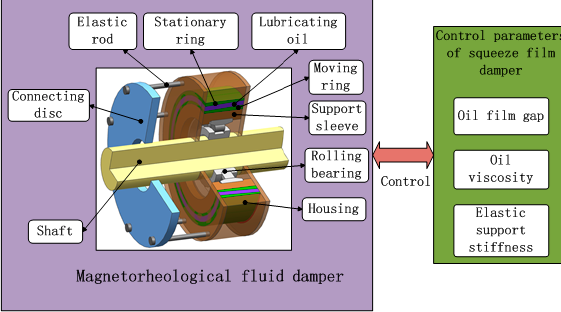
Figure 4. The main process of NSGA-II. 3. Multi Objective Optimization of SFD Parameters